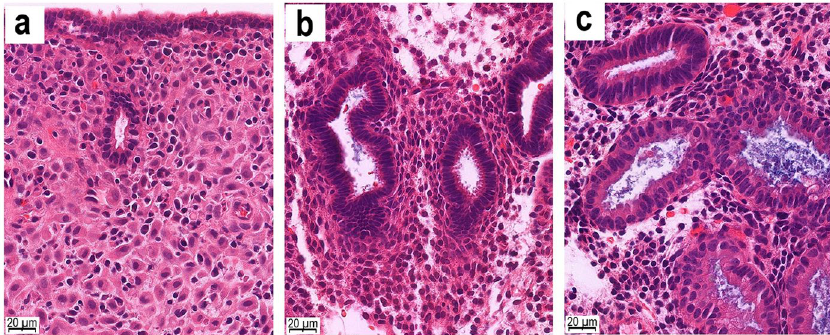
Figure 2. Histopathology of endometrial response after treatment. ( a ) Complete transformation showing a small inactive gland with pseudodecidual stromal change, ( b ) Proliferative endometrium without response, ( c ) Inadequate secretory change and inconspicuous pseudodecidual stromal